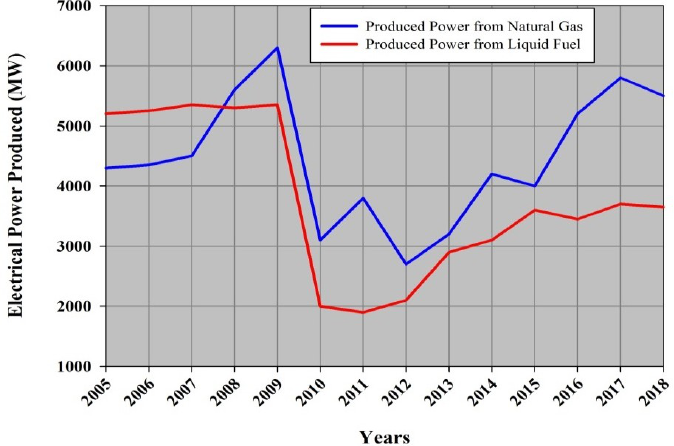
Figure 3. The electric power produced (MW) from liquid fuel and natural gas in power plants in Iraq from 2005 to